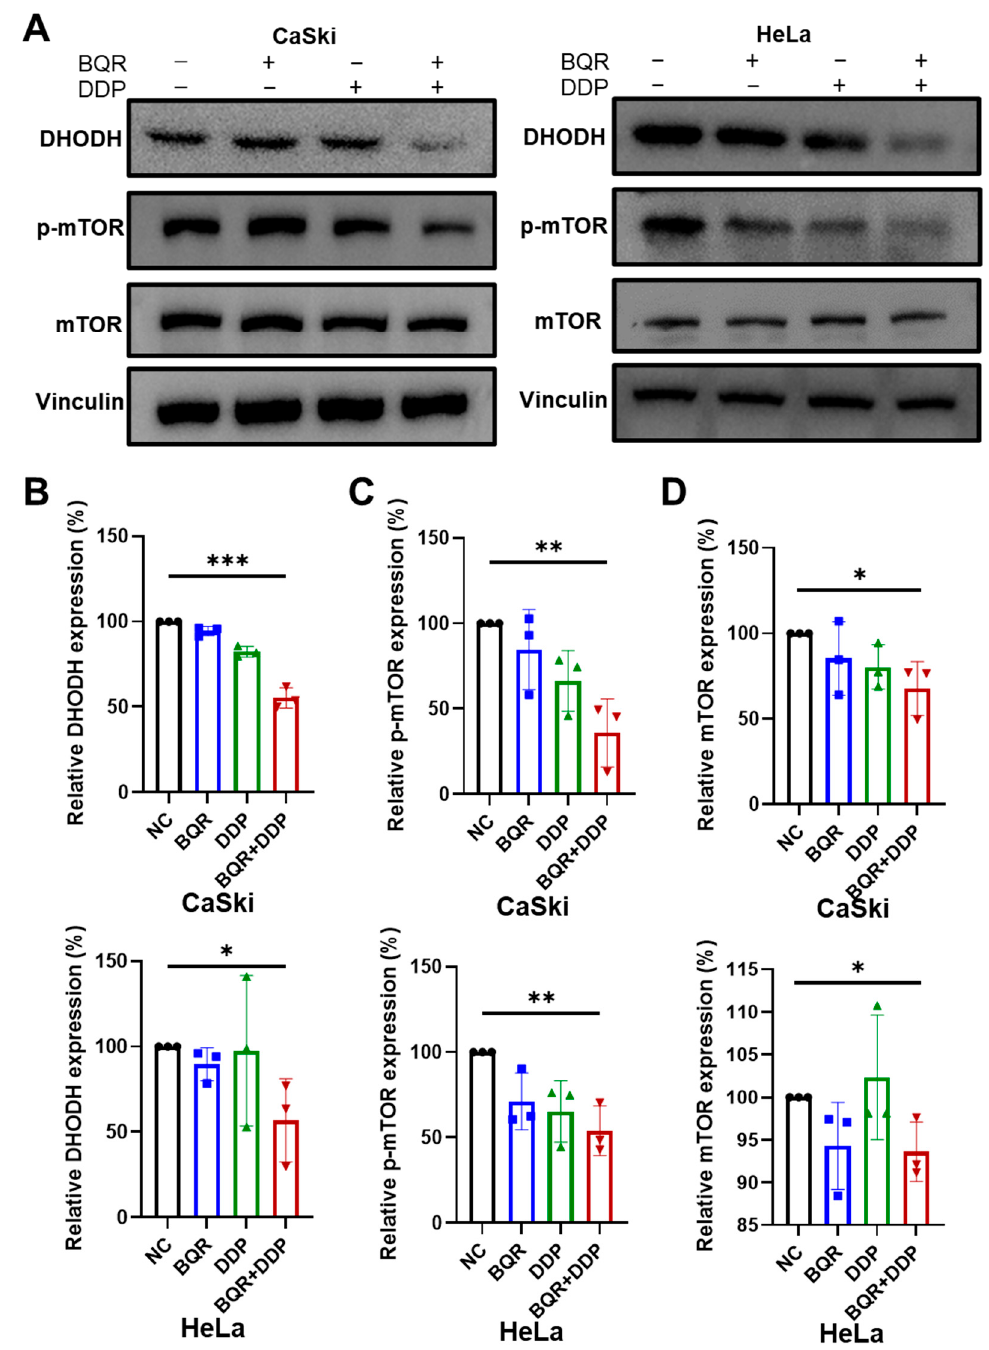
Figure 5. Brequinar (BQR) synergizes with cisplatin (DDP) to suppress the expression of DHODH via inhibiting mTOR pathway. ( A ) The levels of DHODH, p-mTOR and mTOR proteins were